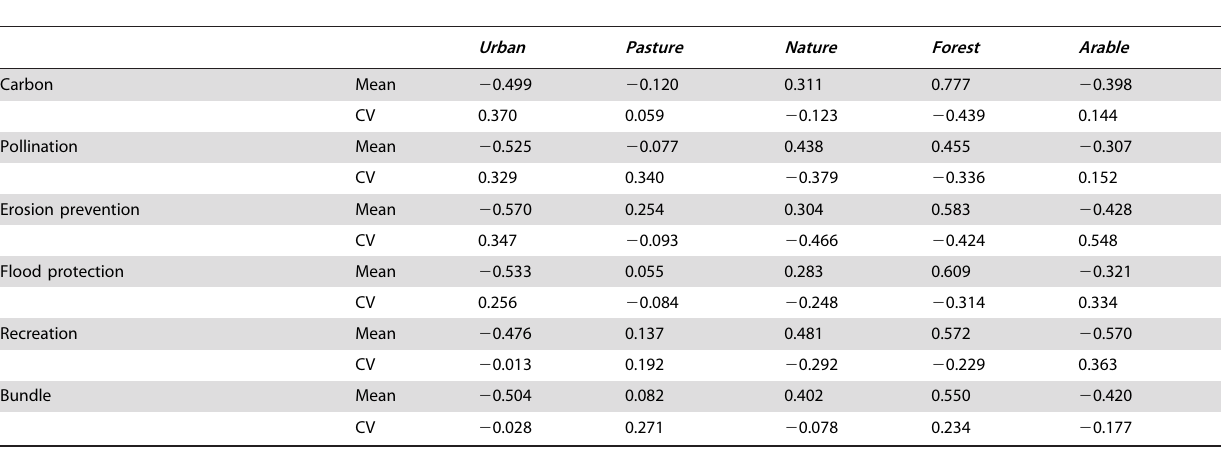
Table 4. Correlations between area percentages of land cover classes* per NUTS2 region and mean and CV of ecosystem service provision.